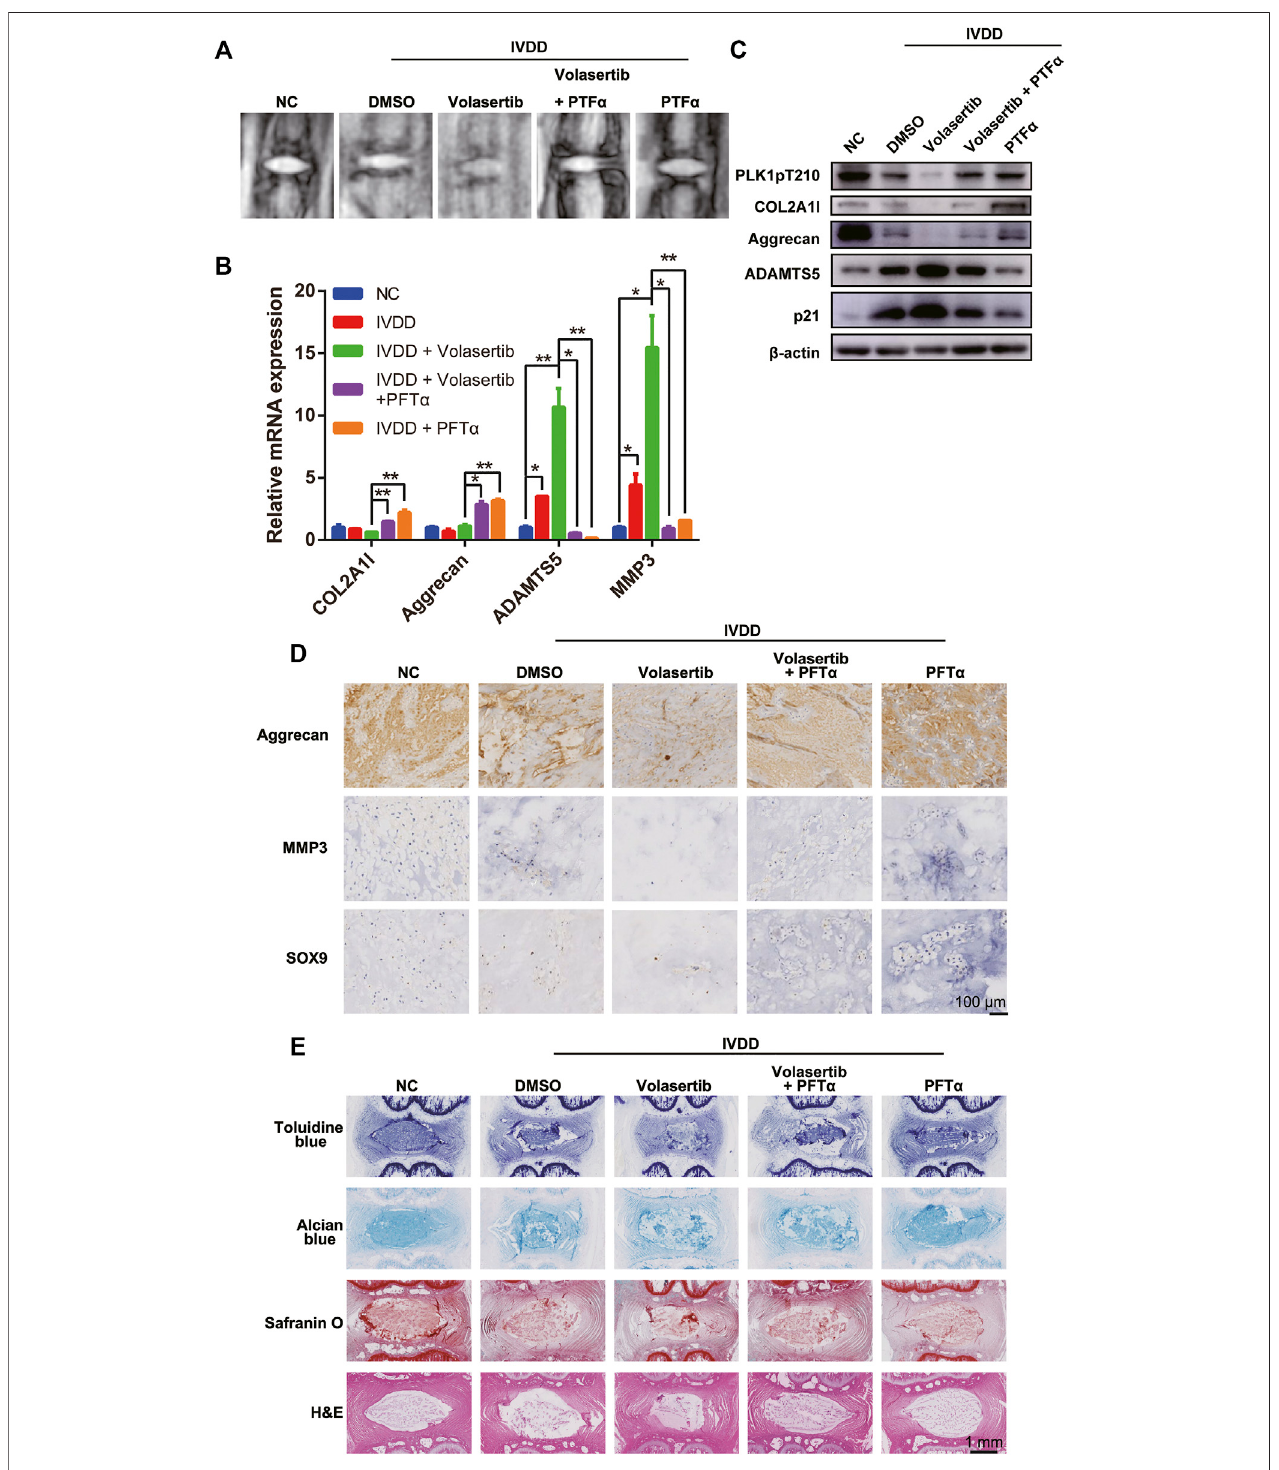
FIGURE5| InhibitionofPLK1kinaseactivityaggravatesIVDDinaratmodel. (A) MRIscansofrattails. (B) ThemRNAexpressionofcollagen,aggrecan,ADAMTS5, and MMP3 was detected in rat tails treated with volasertib or Pi fi thrin- α . (C) The protein expression of PLK1 pT210, collagen, aggrecan, ADAMTS5 and p21 was detected inrat tail tissues. (D) Immunohistologicalstainingofaggrecan, MMP3, and SOX9 in intervertebraldisc from the differentgroups. (E) Toluidine blue, Alcian blue, safraninO,andH&Estainingofintervertebraldiscfromthedifferentgroups.Allexperimentswereperformedinduplicates,anddataarereportedasthemean±SD. * p < 0.05, ** p < 0.01, *** p < 0.001, **** p < 0.0001. SD, standard deviation.